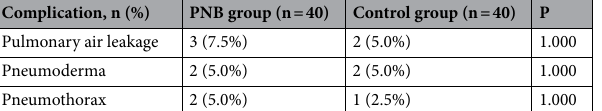
Table 5. Postoperative complications of the patients in the two groups. PNB phrenic nerve block.